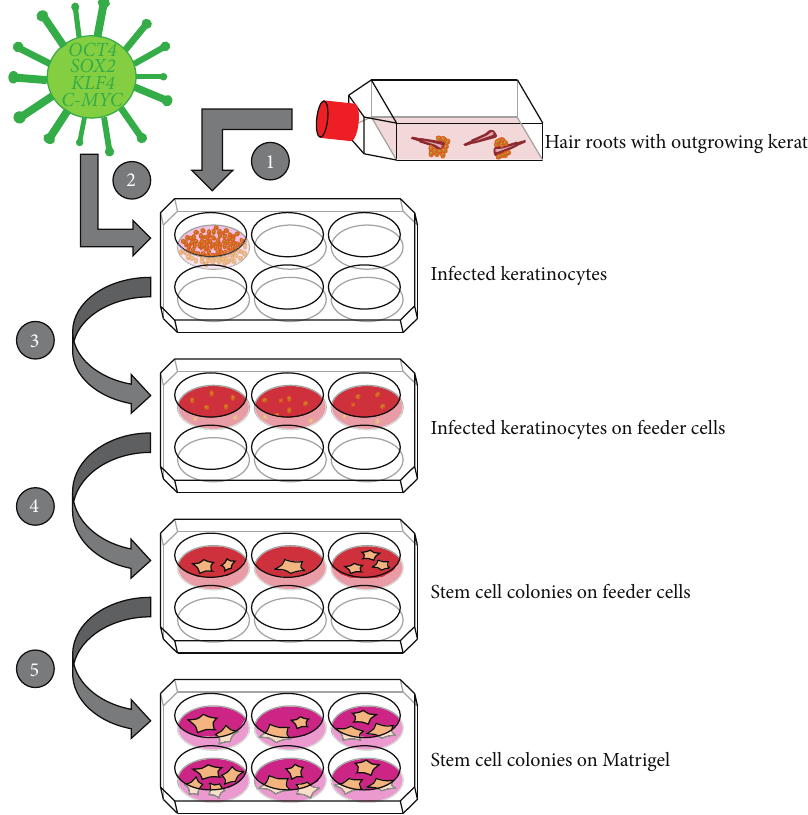
Figure 1: Reprogramming of keratinocytes. (1) Plucked hair is cultured in flasks until outgrowth of keratinocytes. Those are transferred to a six-well plate. (2) Keratinocytes are infected with a lentivirus containing the four reprogramming factors OCT4 , SOX2 , KLF4 , and C-MYC . (3) Infected keratinocytes are transferred to a plate with feeder cells (e.g., rat embryonic fibroblasts) in reprogramming medium. (4) After two to three weeks, stem cell colonies arise, and the uninfected keratinocytes do not proliferate in the reprogramming medium. (5) When the stem cell colonies reach a certain size, they are picked mechanically and a feeder-free system may be used for cultivating the human